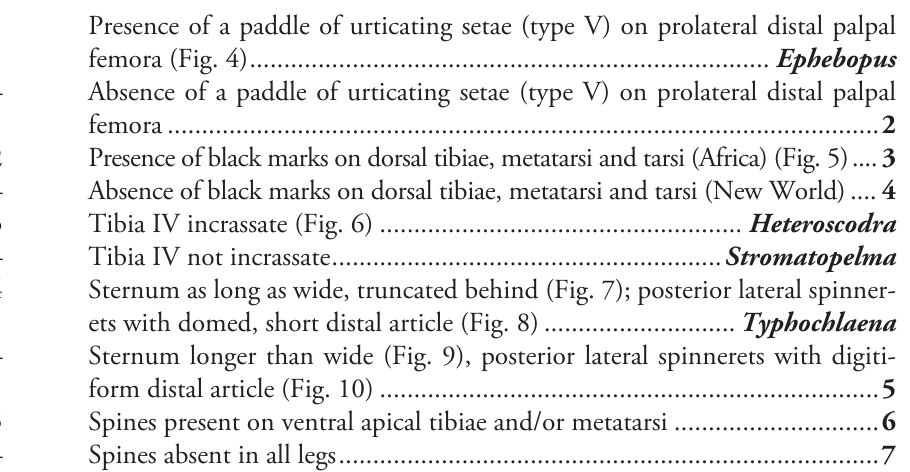
Distribution (Fig. 3): from state of Vera Cruz in Mexico, throughout Central America and some Caribbean islands, northern and central South America to state of São Paulo, Brazil. They can be found from the Atlantic to Pacific coasts. Two genera ( Heteroscodra and Stromatopelma ) are found in West and Central Africa. Key to Aviculariinae genera (Females of A. lynnae sp. n. and A. caei sp. n. are unknown) 1 Presence of a paddle of urticating setae (type V) on prolateral distal palpal femora (Fig. 4) ............................................................................ Ephebopus – Absence of a paddle of urticating setae (type V) on prolateral distal palpal femora ........................................................................................................ 2 2 Presence of black marks on dorsal tibiae, metatarsi and tarsi (Africa) (Fig. 5) .... 3 – Absence of black marks on dorsal tibiae, metatarsi and tarsi (New World) .... 4 3 Tibia IV incrassate (Fig. 6) ..................................................... Heteroscodra – Tibia IV not incrassate ......................................................... Stromatopelma 4 Sternum as long as wide, truncated behind (Fig. 7); posterior lateral spinner- ets with domed, short distal article (Fig. 8) ............................ Typhochlaena – Sternum longer than wide (Fig. 9), posterior lateral spinnerets with digiti- form distal article (Fig. 10) ......................................................................... 5 5 Spines present on ventral apical tibiae and/or metatarsi .............................. 6 – Spines absent in all legs ............................................................................... 7